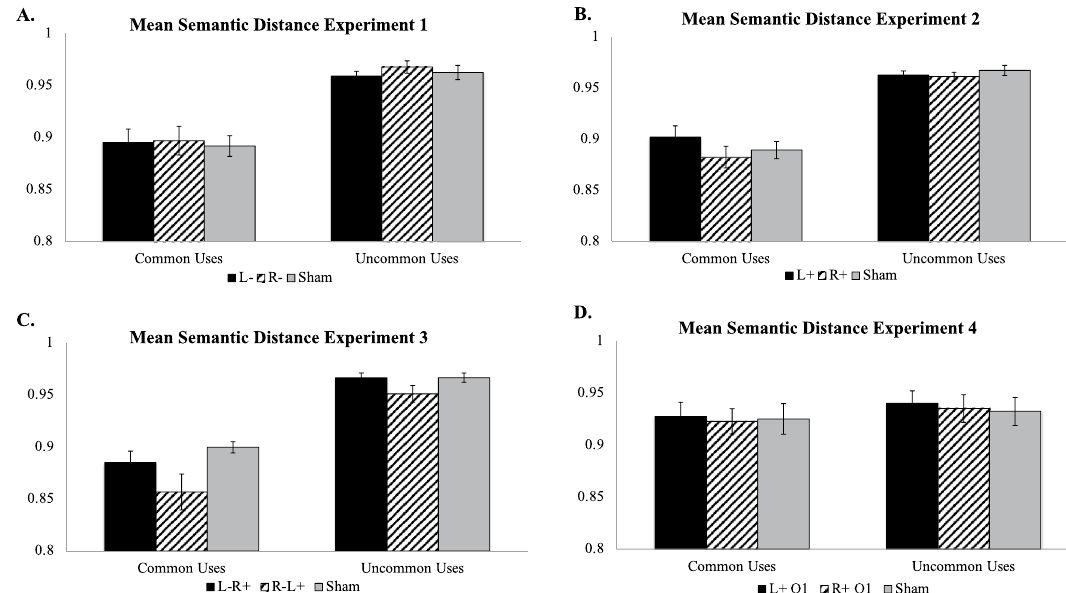
Figure 3. Mean semantic distance for Experiments 1–4 by task and stimulation condition. ( A ) Mean semantic distance for Experiment 1; ( B ) Mean semantic distance for Experiment 2; ( C ) Mean semantic distance for Experiment 3; ( D ) Mean semantic distance for Experiment 4; L- = cathodal tDCS over left ventrolateral PFC; R- = cathodal tDCS over right ventrolateral PFC. L + = anodal tDCS over left ventrolateral PFC; R + = anodal tDCS over right ventrolateral PFC. L-R + = cathodal tDCS over left ventrolateral PFC with concurrent anodal tDCS over right ventrolateral PFC; R-L + = cathodal tDCS over right ventrolateral PFC with concurrent anodal tDCS over left ventrolateral PFC. L + O1 = anodal tDCS over left occipitotemporal cortex; R + O2 = anodal tDCS over right occipitotemporal cortex.